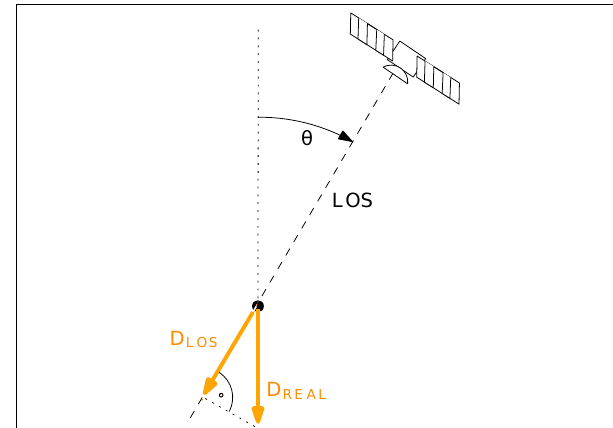
Figure 4. The actual displacement D REAL gets projected on the line-of-sight (LOS) towards the satellite. Depending on the incidence angle θ , different movements are measured. In fact, movements perpendicular to the LOS can not be detected. Note that this is only an issue for non vertical movements. To